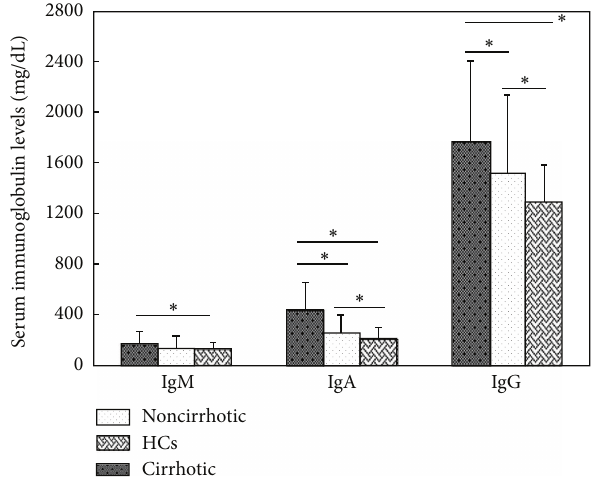
Figure 1: Comparison of immunoglobulin levels (IgG, IgA, and IgM) between patients with and without cirrhosis and healthy controls. ∗ 𝑃 < 0.05 , for the significant differences that were detected among the